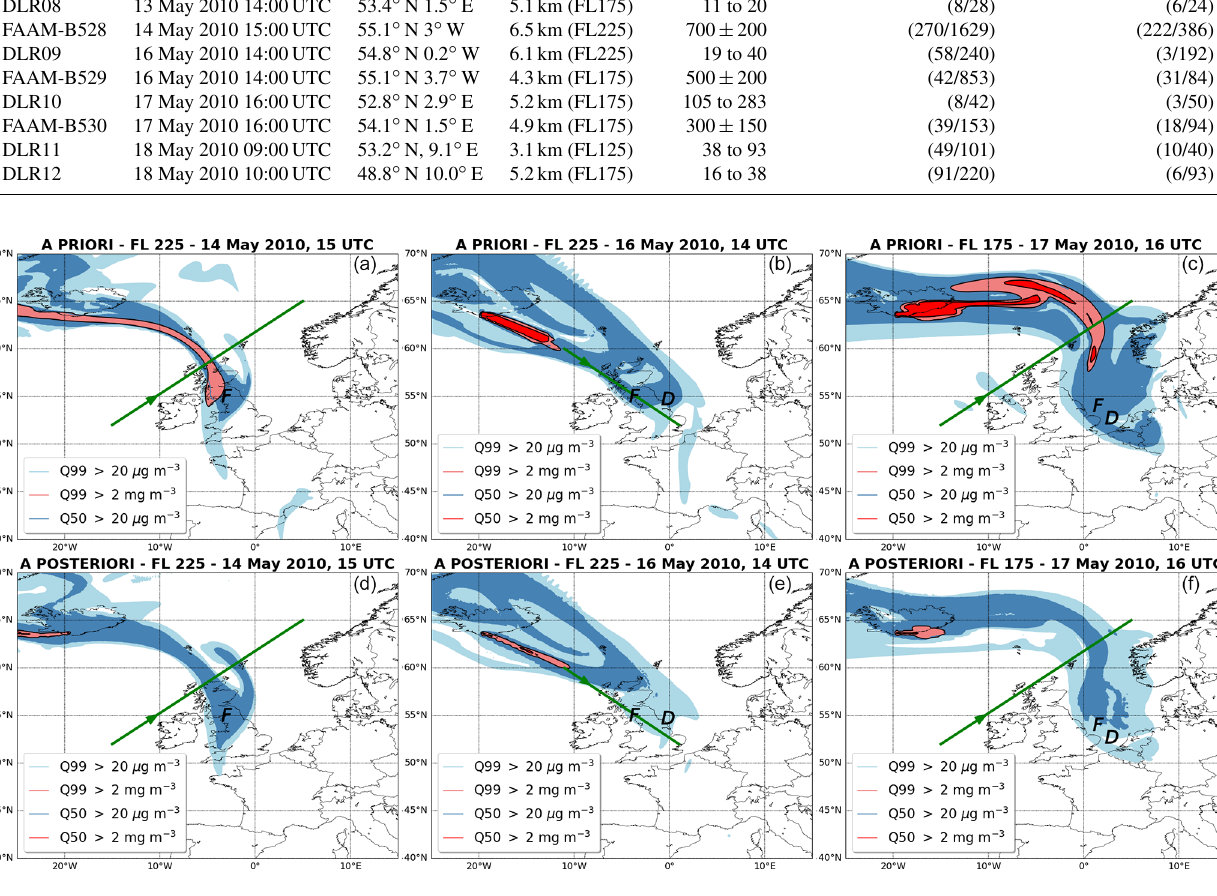
Figure 10. Ash concentrations from the a priori (a–c) and a posteriori (d–f) ensemble, at dates and levels where in situ measurements are available (from left to right: FL225 on 14 May at 15:00UTC, FL225 on 16 May at 14:00UTC, and FL175 on 17 May at 16:00UTC). Blue areas indicate ash concentrations higher than 20µgm − 3 , with different colour tones for Q 50 and Q 99. Red colours refer to concentrations above 2mgm − 3 , with different colour tones for Q 50 and Q 99. Aeroplane locations are indicated by the symbols F and D, for FAAM and DLR flights, respectively. The green lines refer to the cross sections shown in Fig.